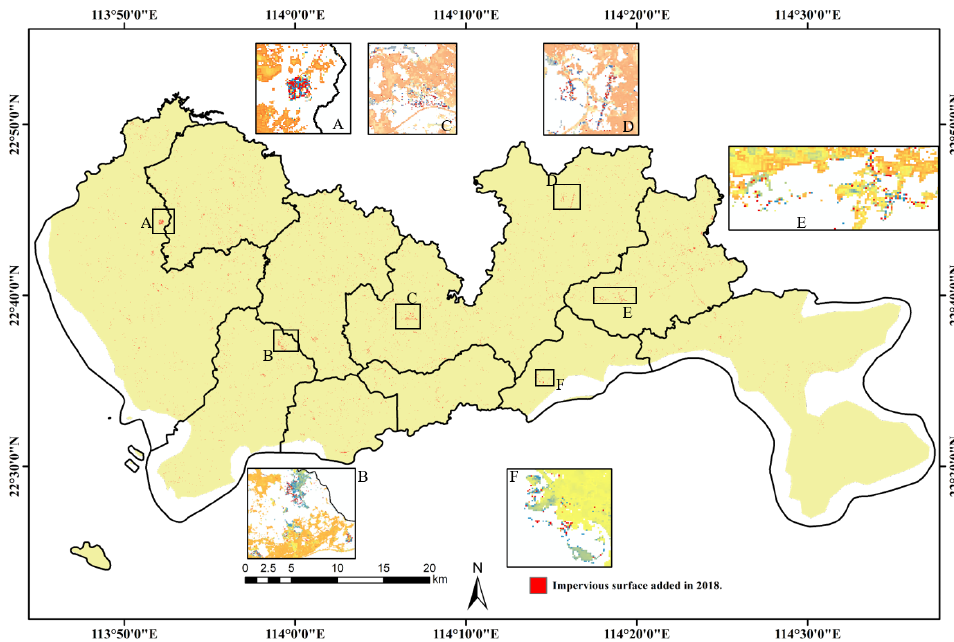
Figure 9. The actual increase and forecast of artificial impervious area in Shenzhen (2018).